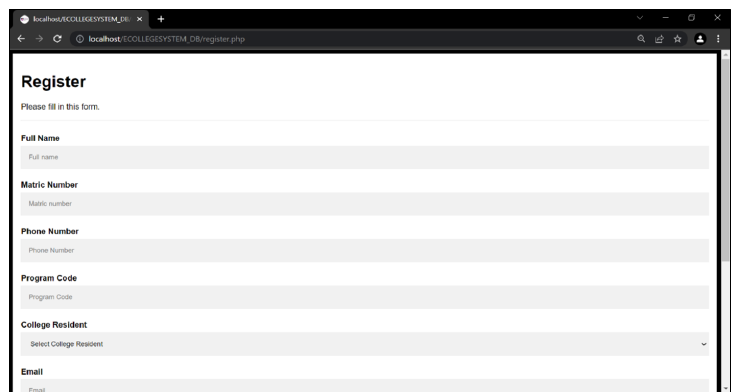
Figure 3. Login page of the E-College Monitoring System.